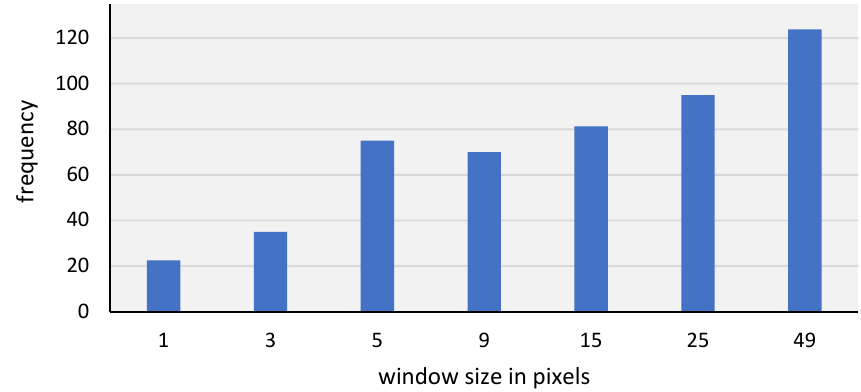
Figure 9. Frequency of window sizes of the 500 most important features used for the classification. Note: The window size of one pixel represents the unfiltered raster products.